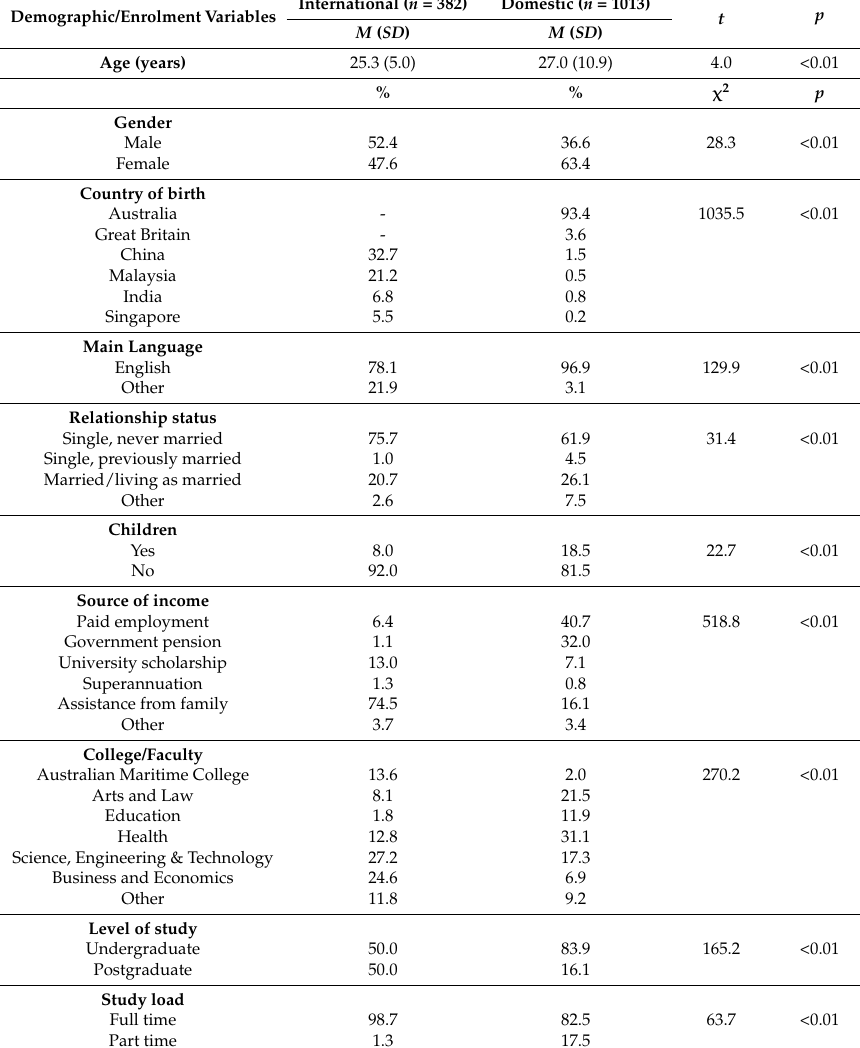
Table 1. Demographic and enrolment characteristics of study participants by student